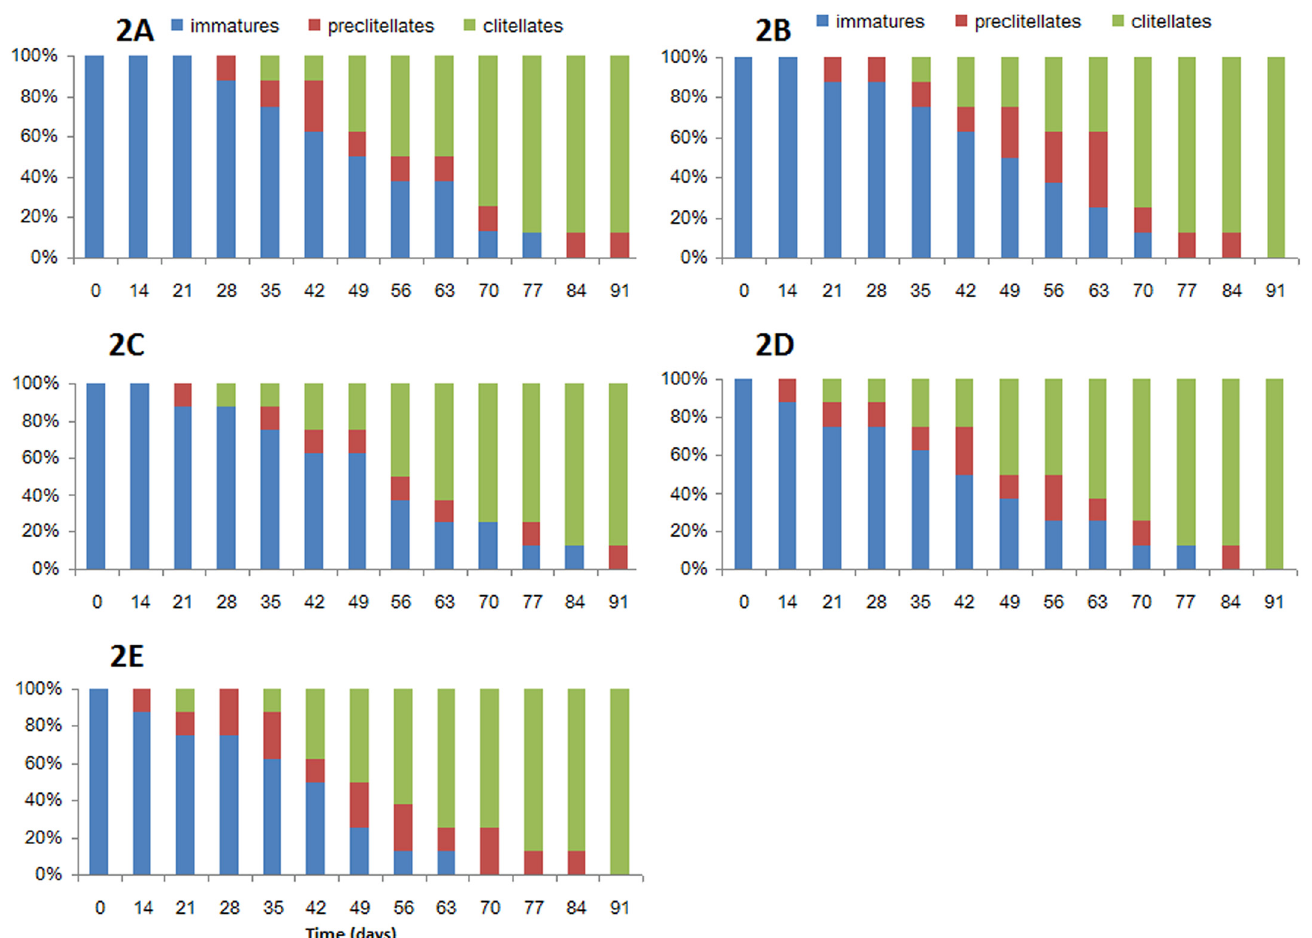
Fig 2. Sexual development of Eisenia fetida in the different